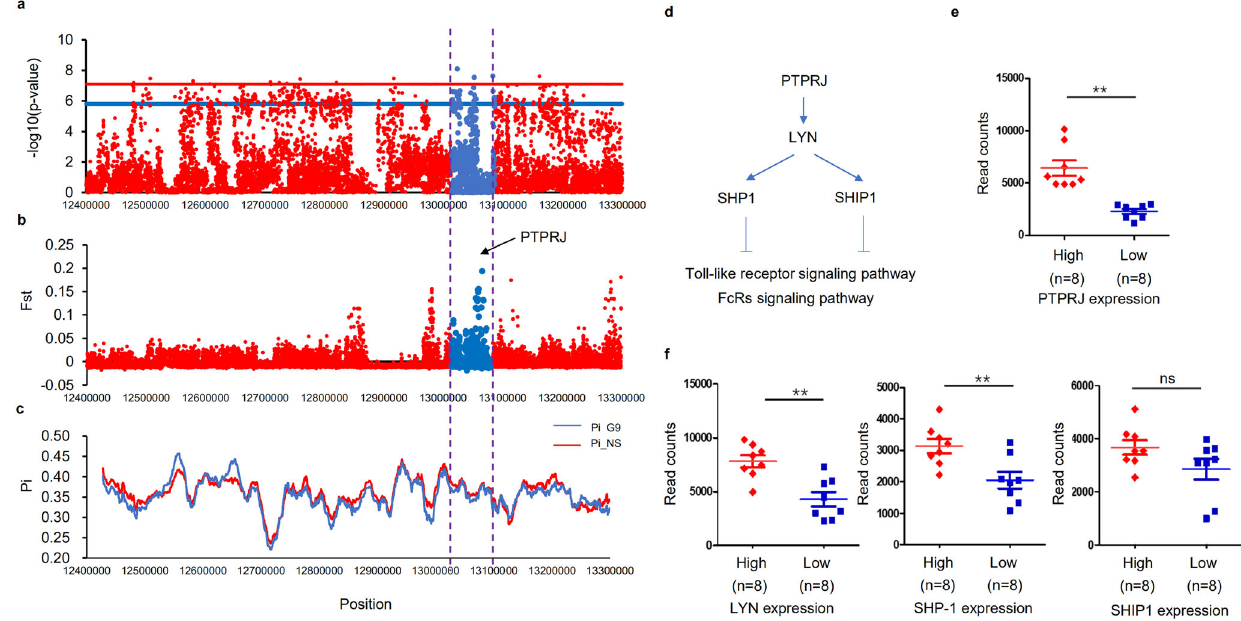
Fig. 4 Functional genomic basis of H/L values in chickens. a GWAS revealed strong association of chicken H/L with a 1-Mb region on chromosome 5. b Fixation index (Fst) between G9 and NS chickens for all SNPs along the 1-Mb region. c Nucleotide diversity (Pi) of G9 (blue line) and NS chickens (red line) from 12.4 to 13.3 Mb on chromosome 5. d Schematic overview of PTPRJ function. e mRNA expression of PTPRJ by RNA-seq in individuals having high and low PTPRJ expression. f mRNA expression of LYN , SHP-1 , and SHIP-1 by RNA-seq in individuals having high and low PTPRJ expression. The indicated signi fi cance (**) is based on one-way ANOVA, ns: not signi fi cant ( p > 0.05). Data are expressed as the mean ± standard deviation